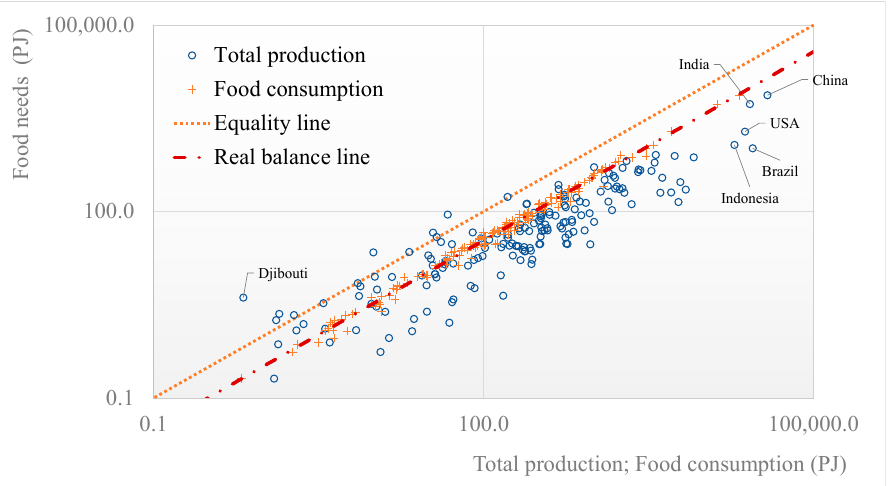
Figure 2. Food production and consumption vs. food needs, expressed in energy units (PJ) in different countries (2019).